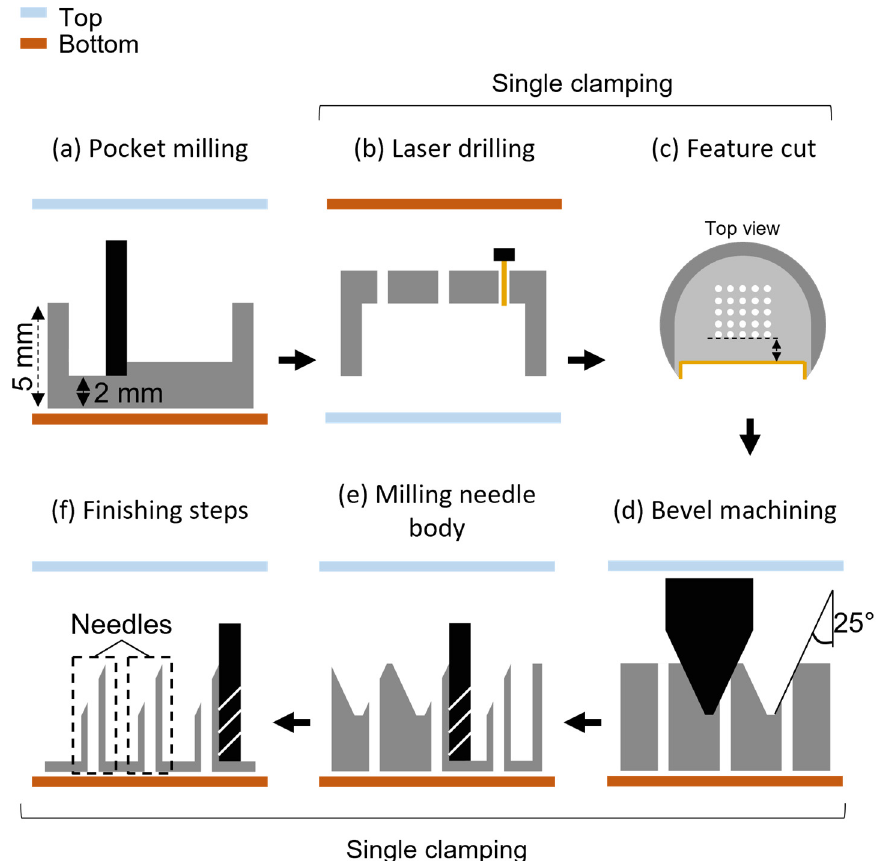
Figure 1. Overview of the HMNA fabrication process. ( a ) A pocket with a 2 mm thick bottom is created, in which ( b ) lumens are laser ablated, followed by ( c ) a reference feature cut (yellow line) in a single step. Then, in a single clamping on the micro-milling center, ( d ) the bevels were machined first followed by ( e ) milling the needle body and ( f ) finishing